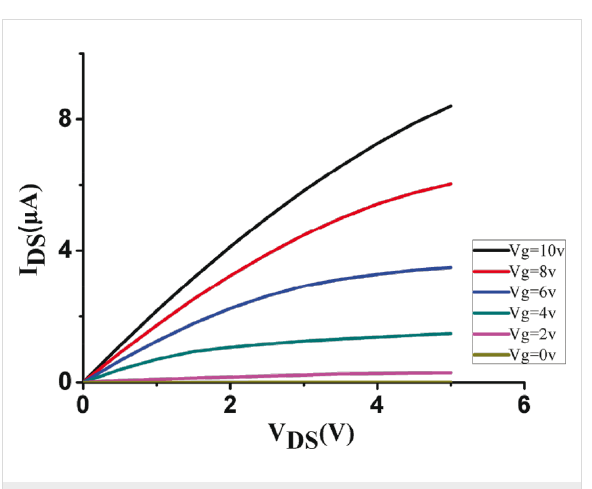
Figure 6: I ds – V ds DC measurement results.